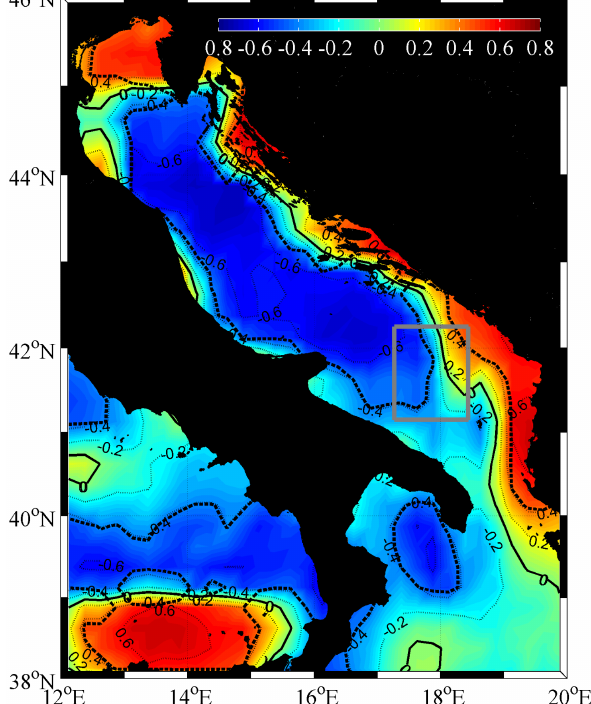
Figure 6. Spatial distribution of the correlation coefficient of the JFM NAO index and wind-stress vorticity, 1988–2011 (coloured area and dotted lines). The bold solid and dashed lines indicate the 0 correlation and the 95% significance isoline, respectively. The square shows the area used to estimate the time series in Fig.